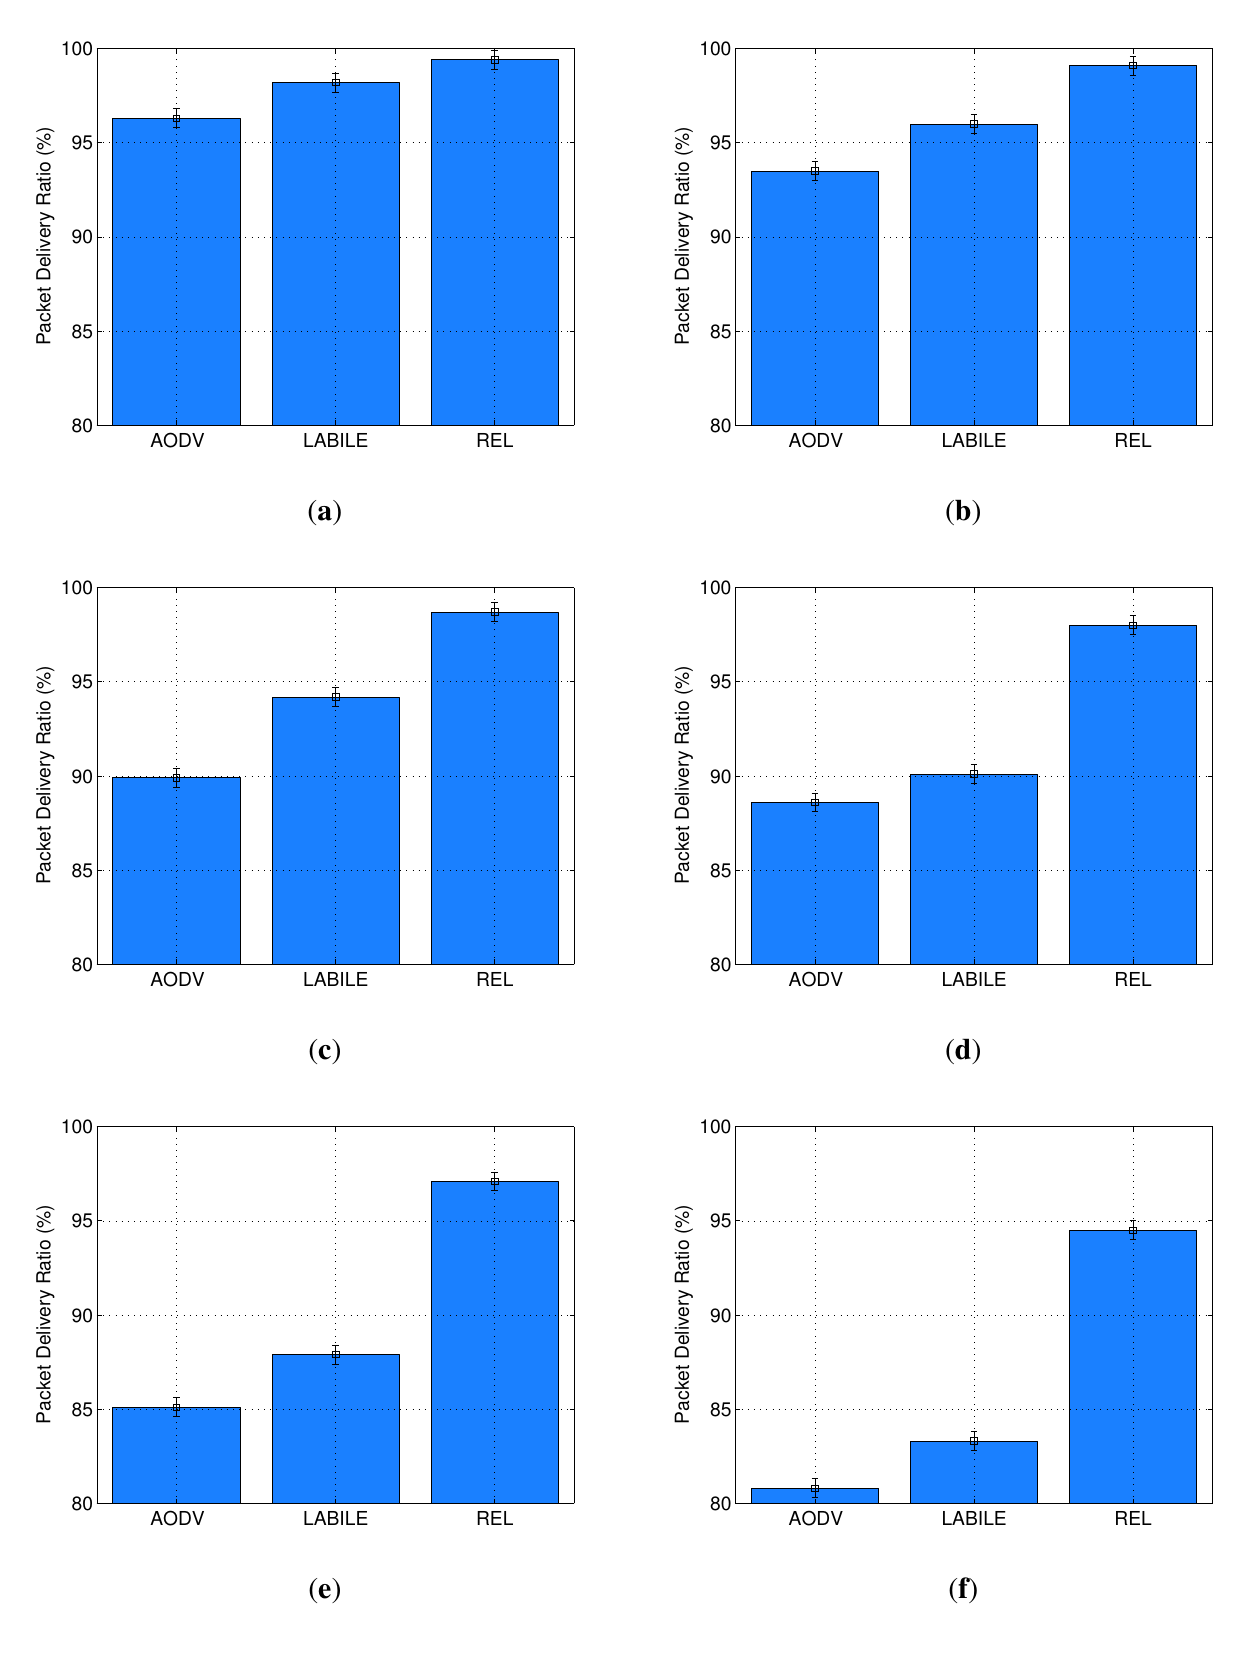
Figure 9. Packet delivery ratio in simulation experiments. ( a ) 20 Nodes, ( b ) 40 Nodes, ( c ) 60 Nodes, ( d ) 80 Nodes, ( e ) 100 Nodes, ( f ) 200